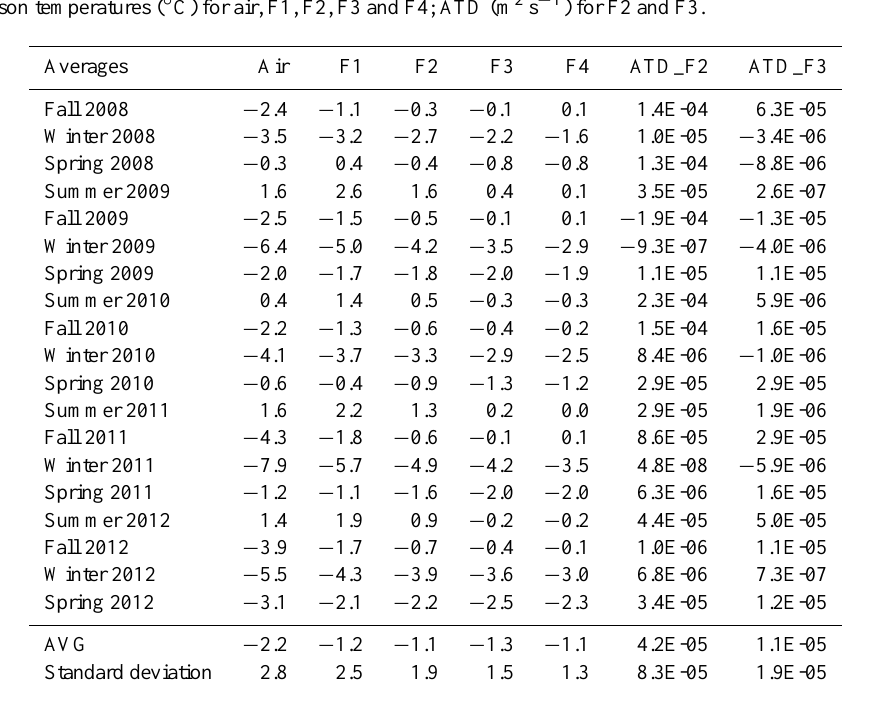
Figure 6. Loess time series decomposition for F1, F2, F3 and F4. Table 3. Average season temperatures ( ◦ C) for air, F1, F2, F3 and F4; ATD (m 2 s − 1 ) for F2 and